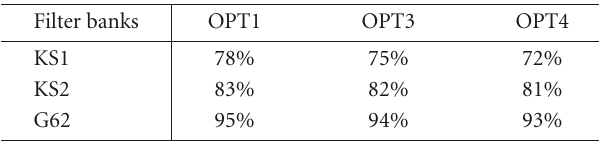
Table 4: Statistical summary of the lossy compression results for twenty seven test images, each coded at compression ratios of 128, 64, 32, and 16. Percentage of cases where the OPT1, OPT3, and OPT4 optimal designs outperform the KS1, KS2, and G62 (quin- cunx) filter banks.